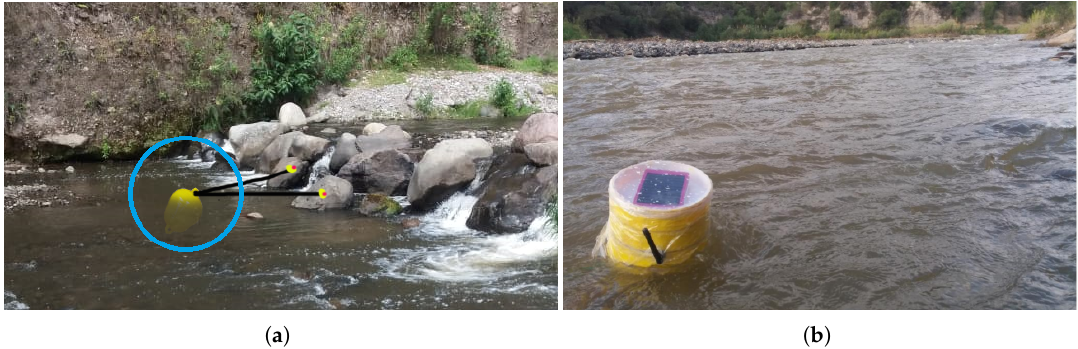
Figure 9. Anchored node acquiring and sending data to interface. ( a ) Simulation. ( b ) Real conditions.